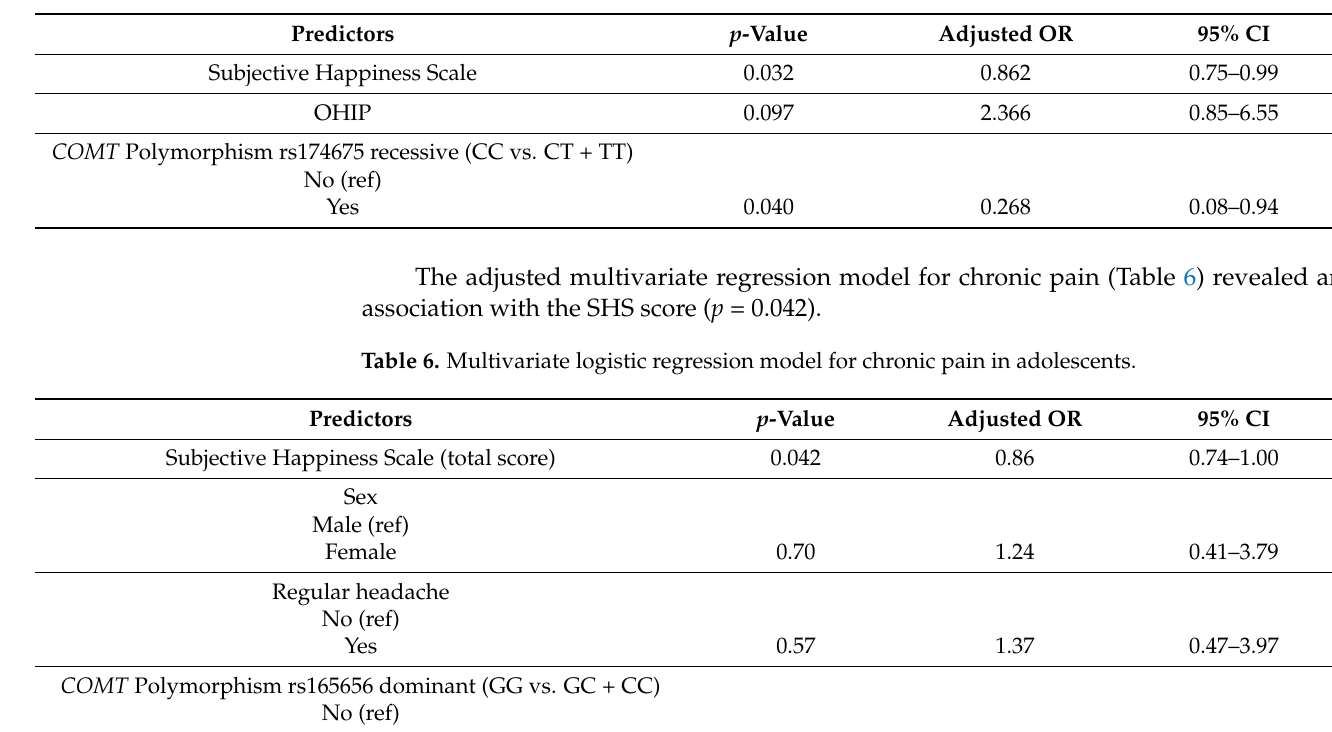
Table 5. Multivariate logistic regression model for depression in adolescents.